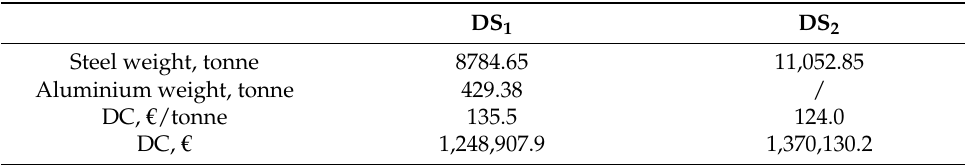
Table 3. Dismantling costs for the evaluated design alternatives.